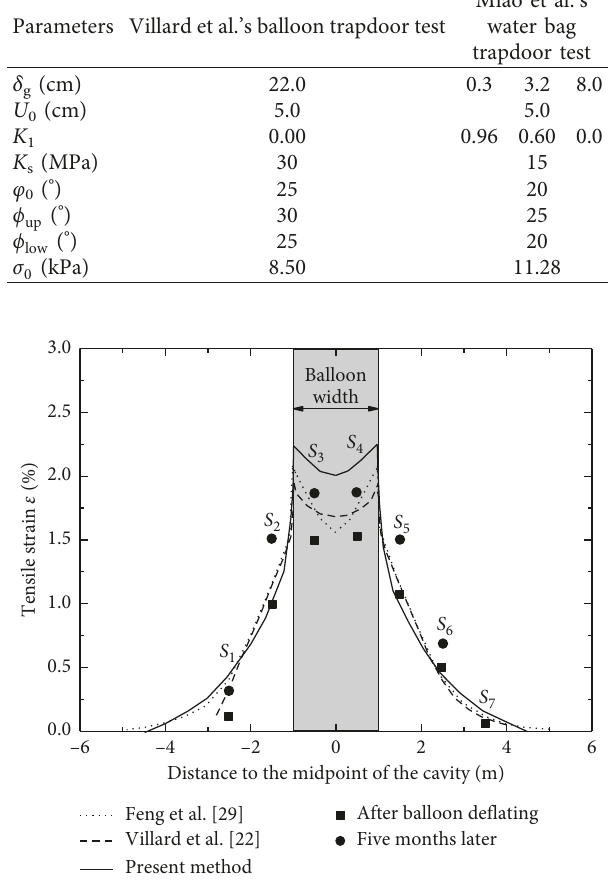
Figure 11: Comparison of test tensile strains and calculated